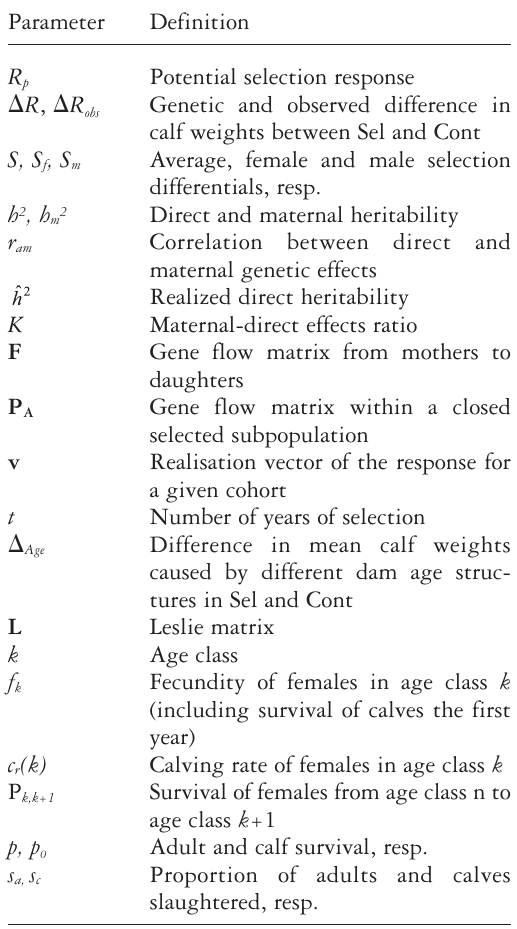
Table 1. Definitions of